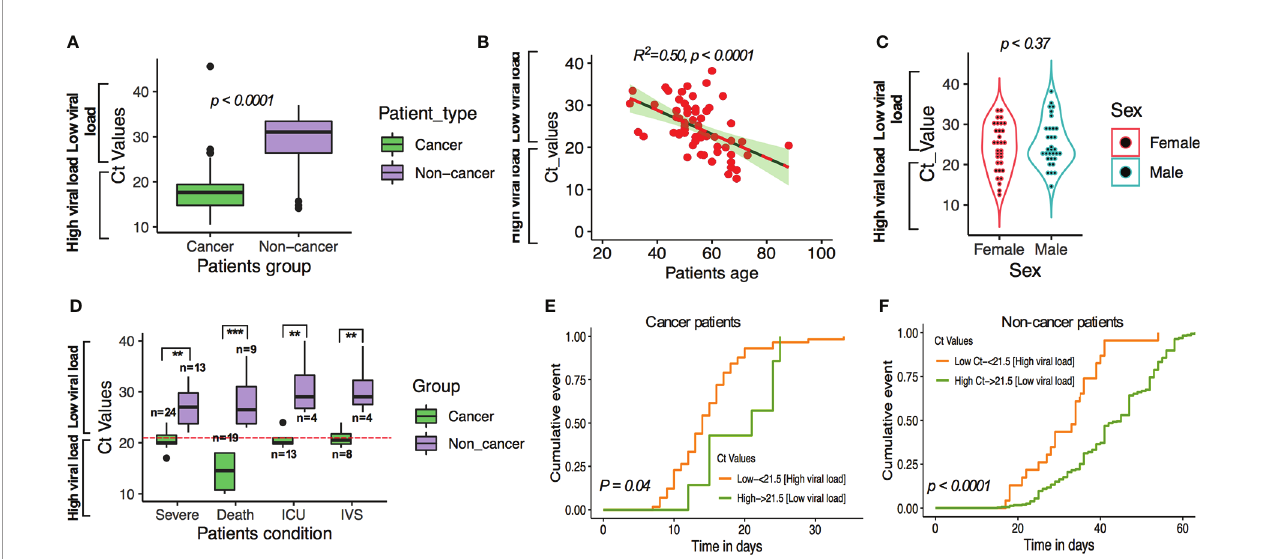
FIGURE 4 | (A) SARS-CoV-2 Ct (cycle threshold) values in cancer and non-cancer patients derived from nasopharyngeal swab test. (B) Linear regression of age and viral load. (C) t-test comparing the viral load among male and female cases. (D – F) SARS-CoV-2-viral load and patients ’ severe condition in patients with and without cancer. **P ≤ 0.01; ***P ≤